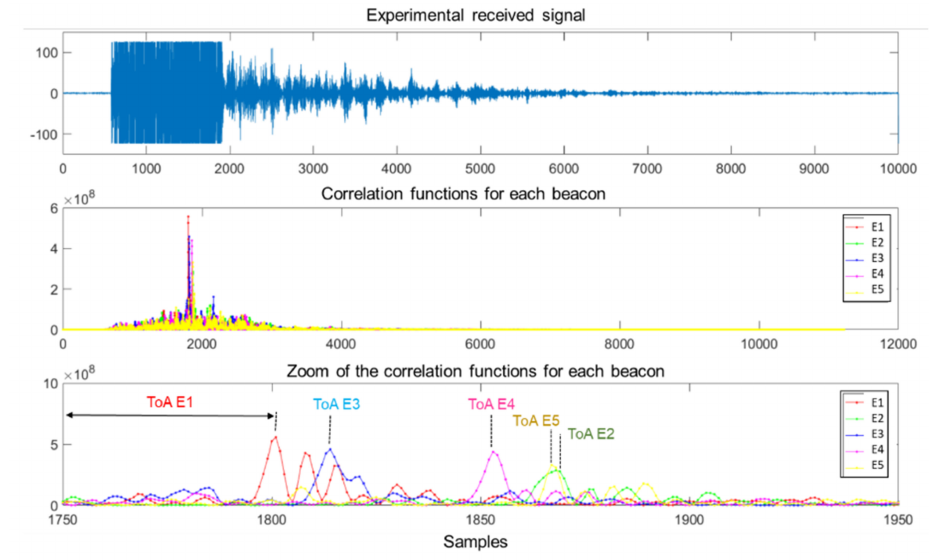
Figure 19. Experimental acquisition for point R1: the received signal ( top ); the correlation functions between this incoming signal and the codes emitted by beacons Ei ( middle ); and magnification of the area of interest, where the maximum values of those correlation functions can be observed ( bottom ).